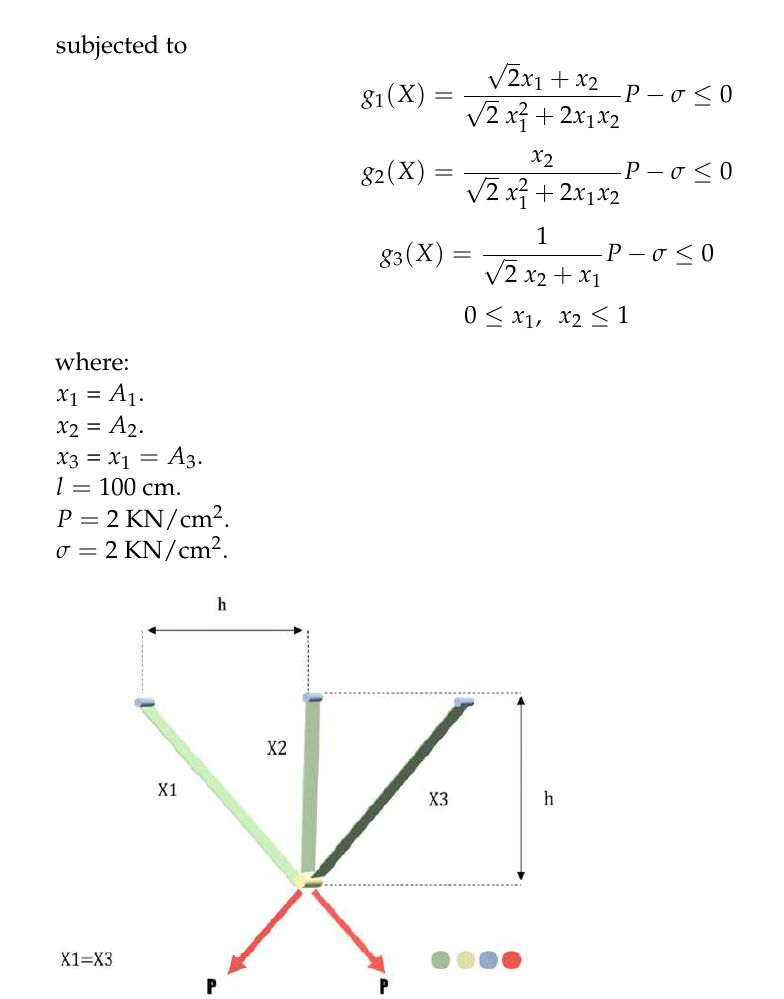
Table 5. Comparison of the results of the algorithms for the three-bar truss design problem.